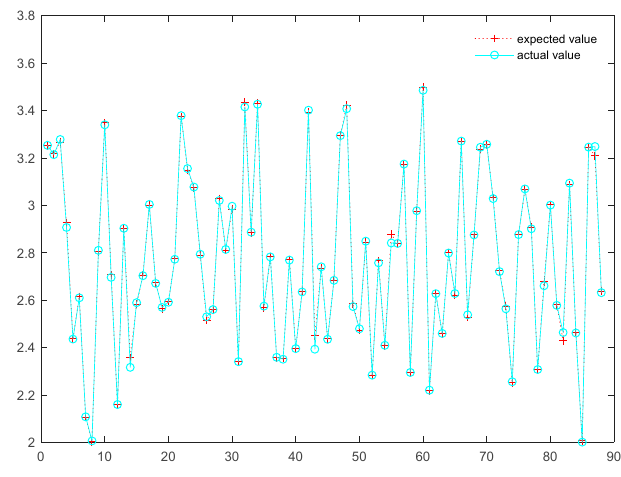
Figure A4. Relative error variation of Wannian community.